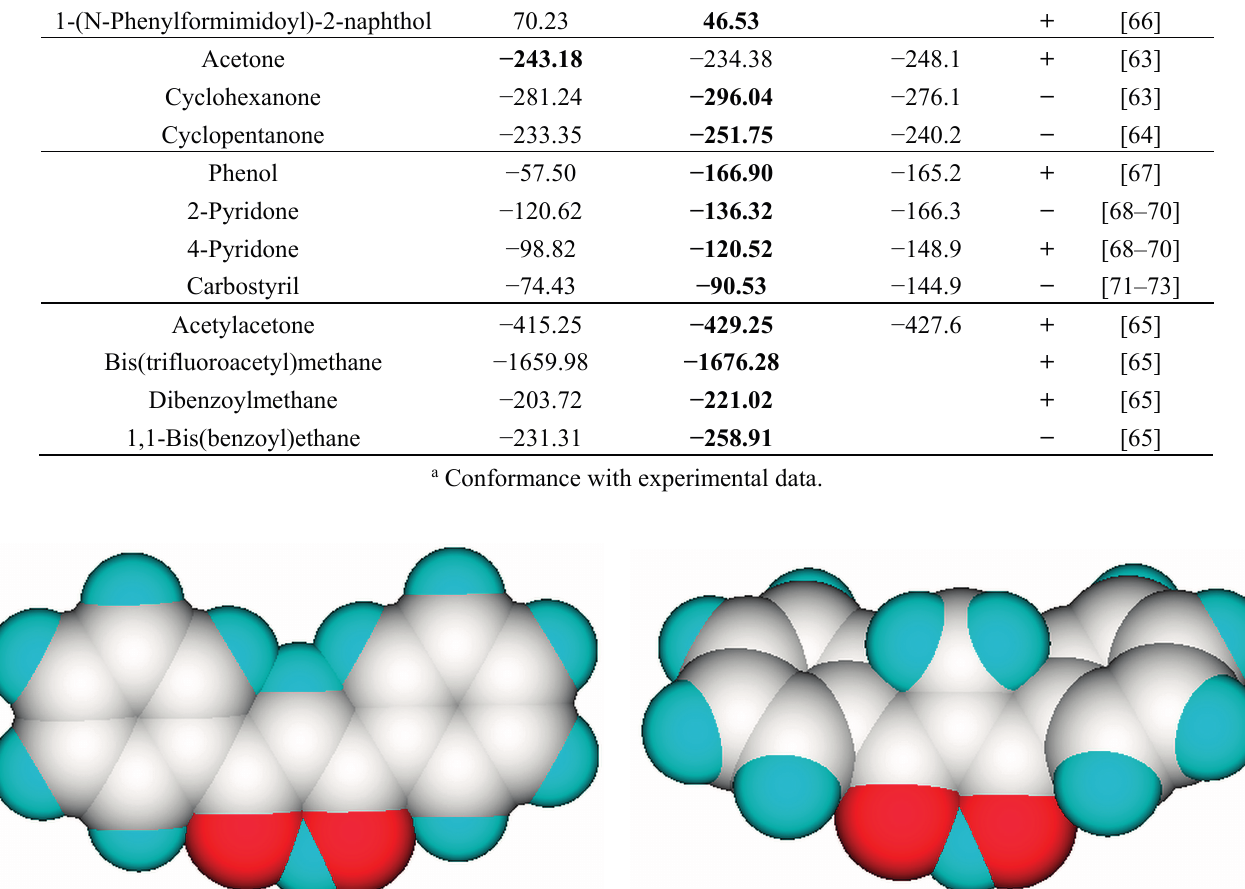
Table 7. Thermodynamic Data (kJ/mol) of Tautomeric Ketones and β -Diketones. Compound